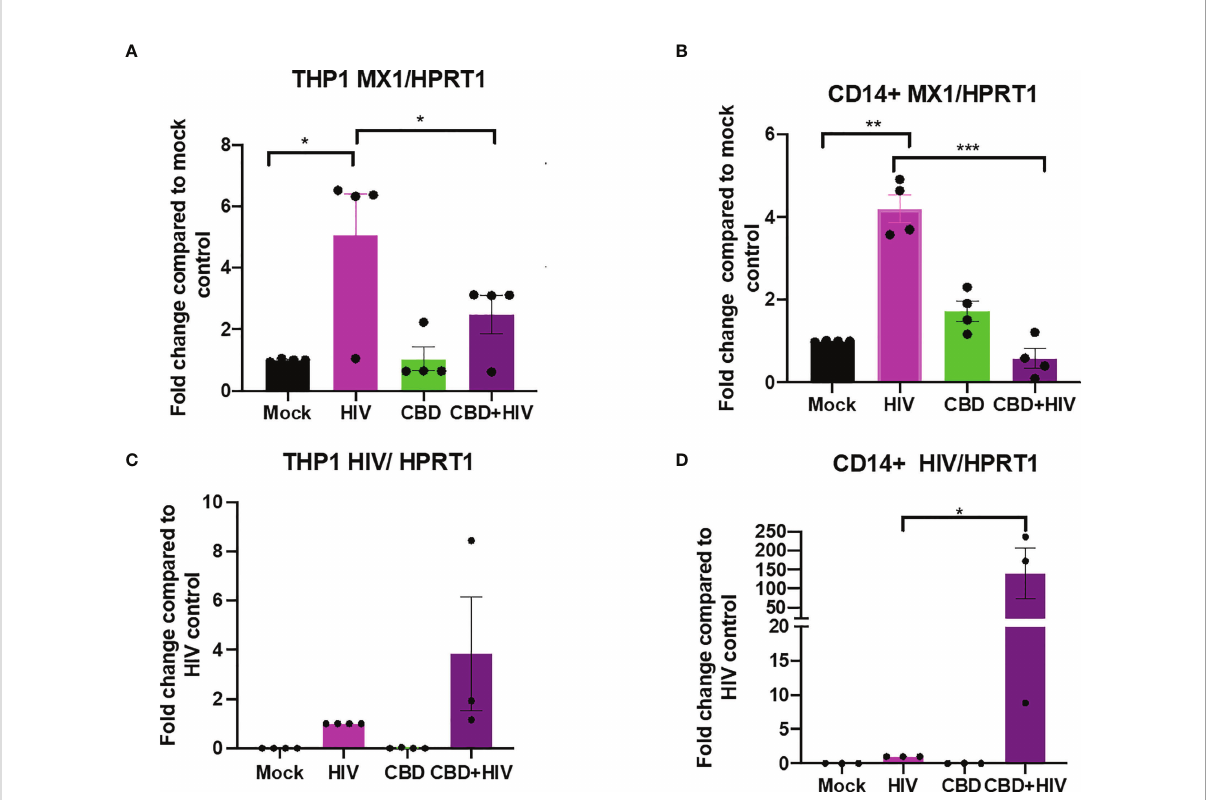
FIGURE 5 CBD suppresses ISG MX1 expression level and increase HIV RNA level 24 hours after infection in THP-1 cells and macrophages. THP-1 cells were stimulated for 5 days with PMA and primary monocytes were differentiated using M-CSF for 5 days. Cells were treated with vehicle or CBD for 24 hours followed by infection with HIV for 24 hours and harvested. Fold change of expression level of MX1/HPRT1 compared to mock in (A) THP-1 cells and (B) CD14+ primary macrophages. Fold change of HIV RNA expression level compared to vehicle treated HIV infected (C) THP-1 cells or (D) CD14+ primary macrophages as measured by real time PCR. *p<0.05, **p<0.005,